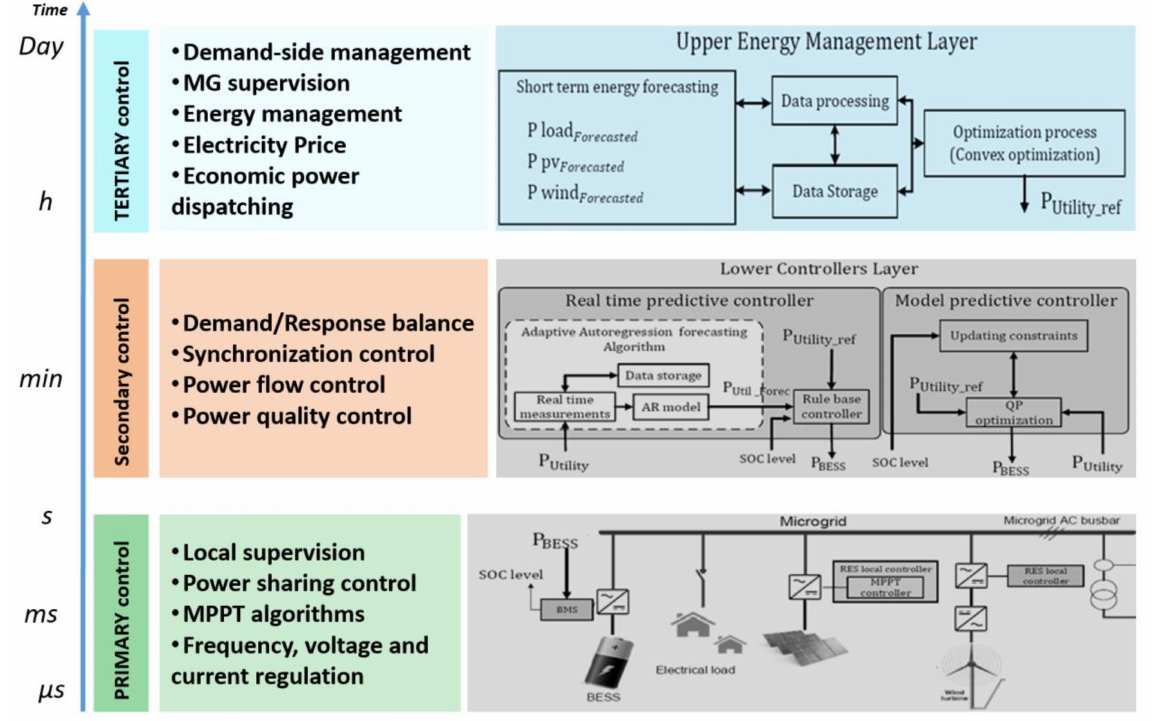
Figure 3. Hierarchical control